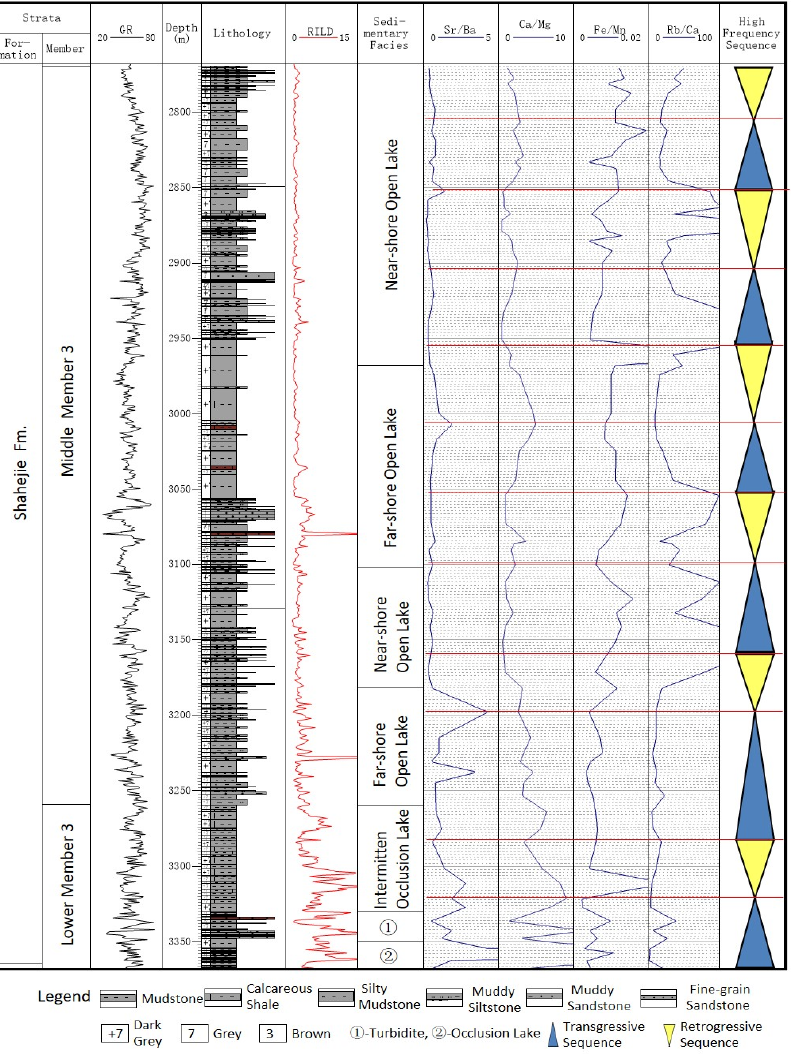
Figure 4. The element ratio of the shale and high-frequency sequence division in Well Niu 38 of Dongying Depression.